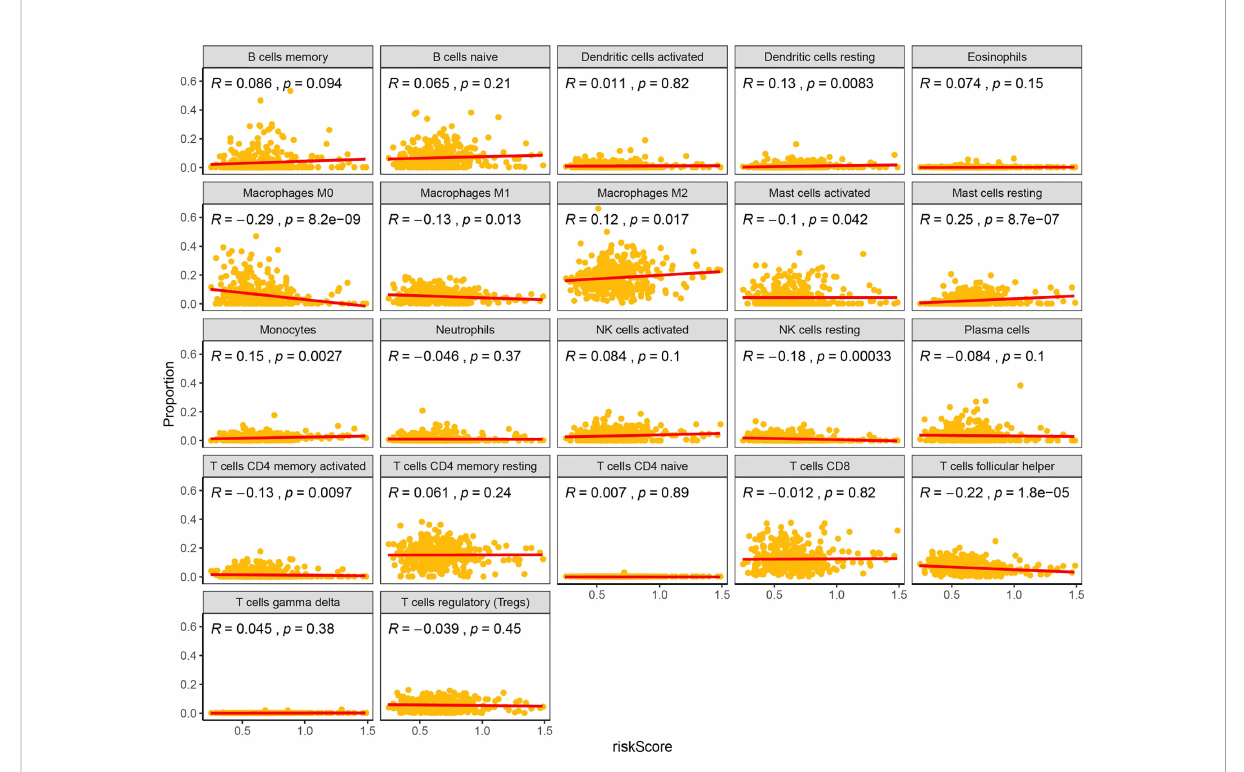
FIGURE 9 Relationships between the RiskScore and in fi ltration abundances of 22 immune cell